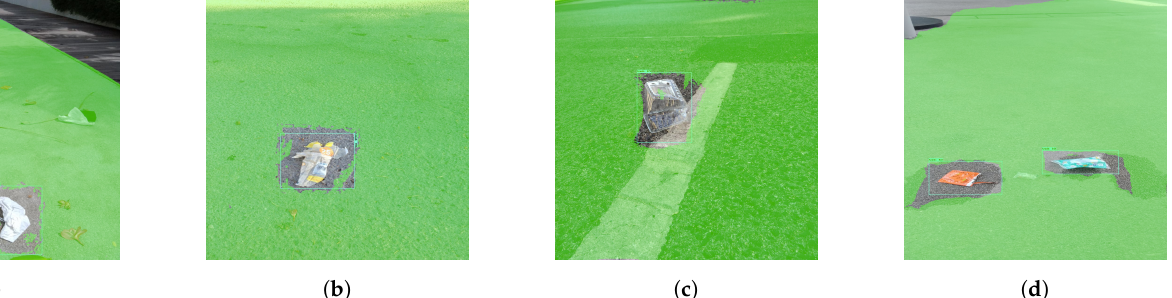
Figure 11. Pavement segmentation and the garbage detection results in ( a – d ).